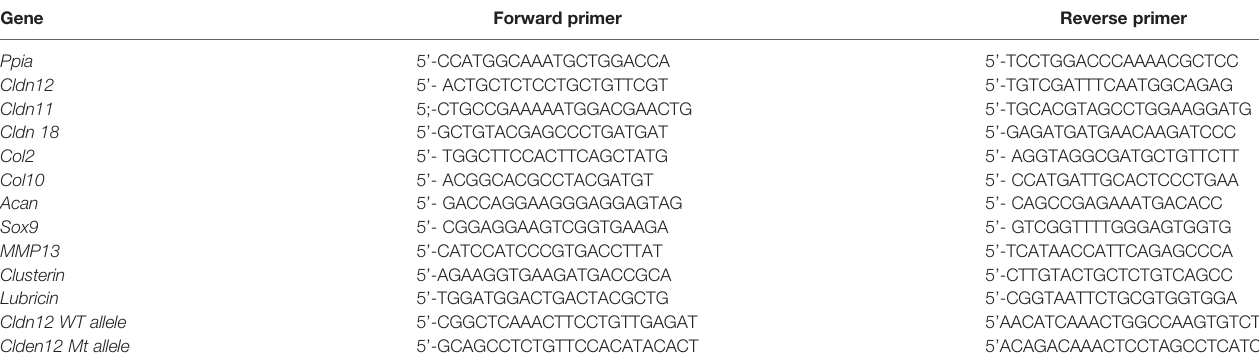
TABLE 1 | Primer sequences used for real time PCR and